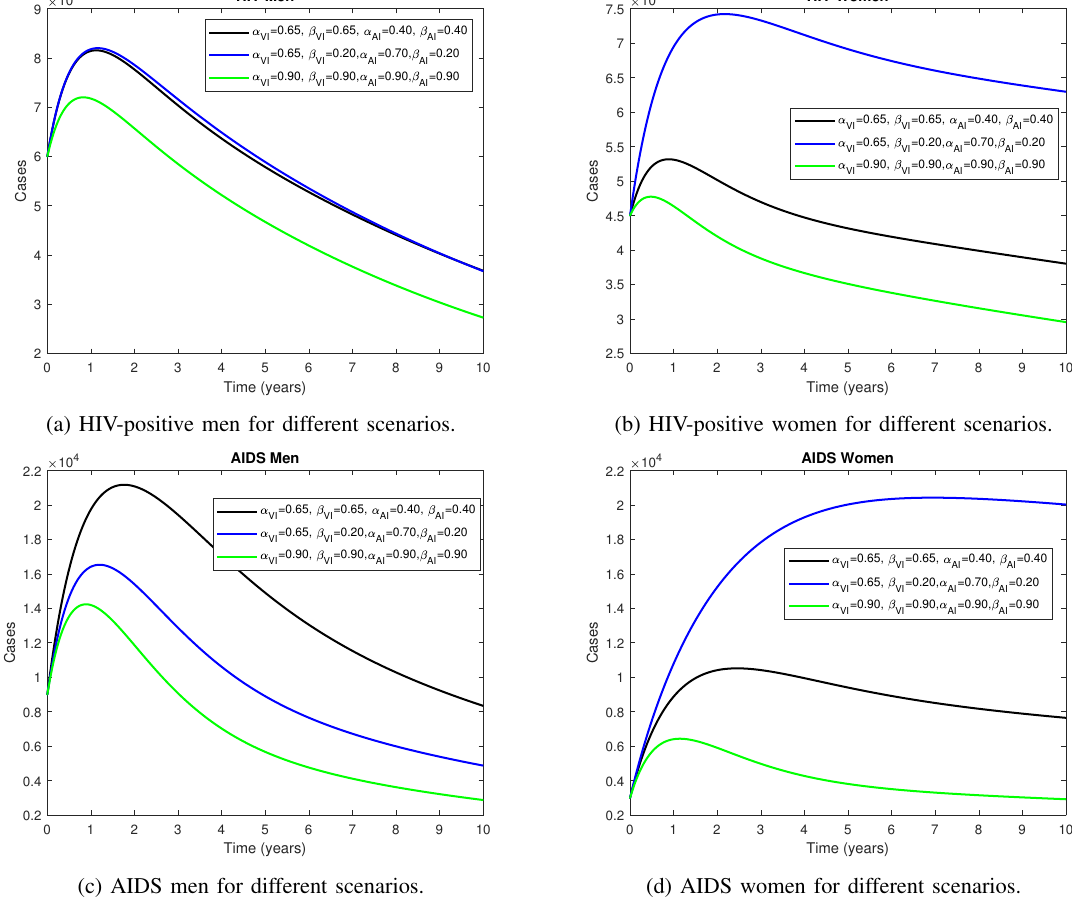
(a) HIV-positive men for different scenarios. (b) HIV-positive women for different scenarios.